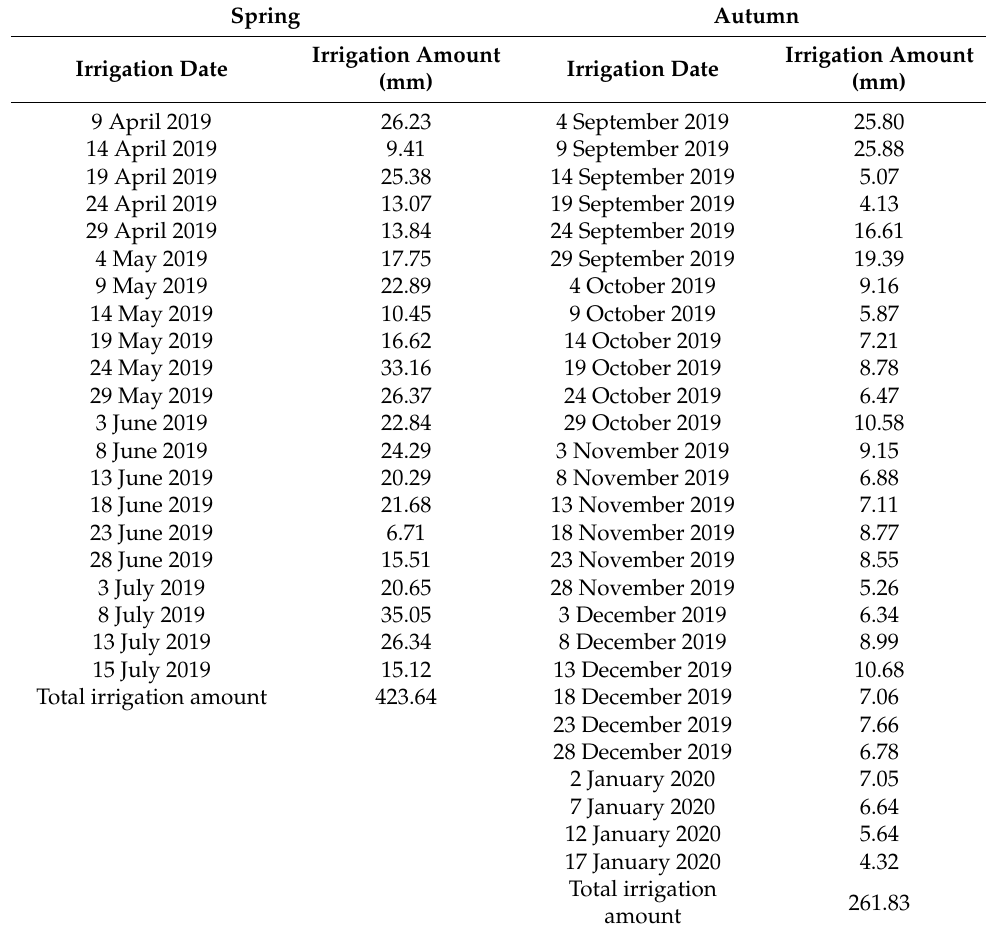
Table A2. Irrigation date and amount during both growing